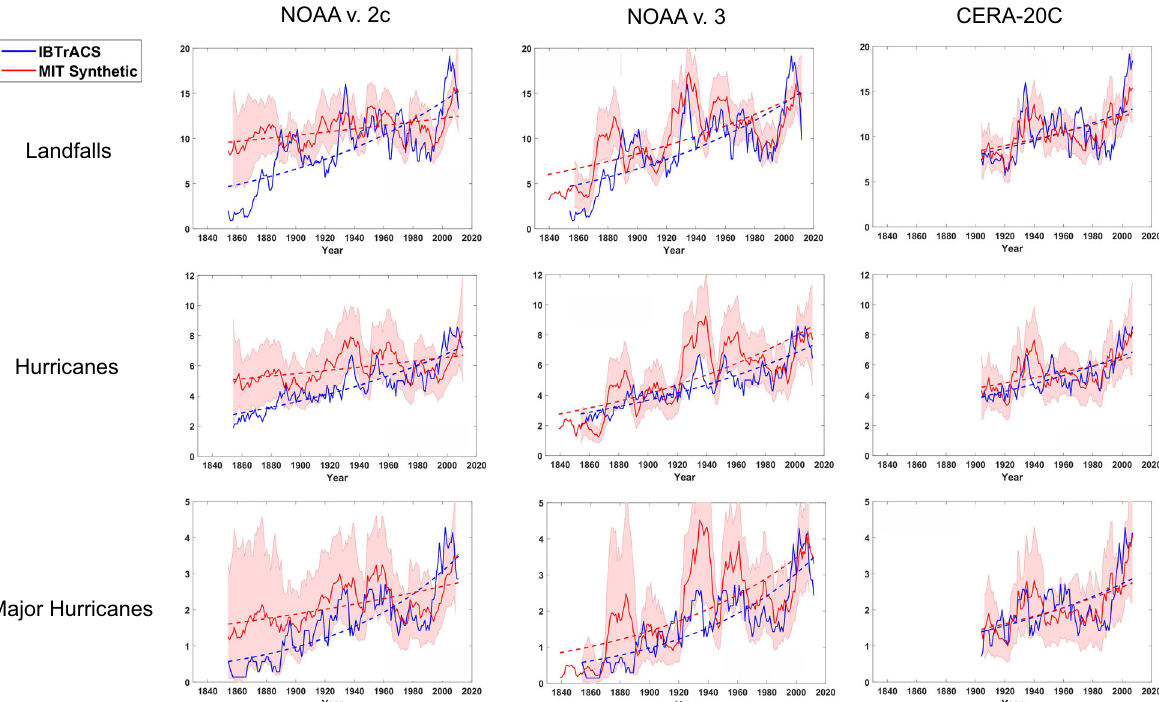
Fig. 1 Time series of North Atlantic landfall events, basin hurricanes, and major hurricanes. The landfall frequency (top row) includes only storms whose lifetime maximum winds speeds exceed 40 kts (21 ms − 1 ). Middle row shows basin frequencies and bottom row shows basin-wide major hurricane frequency. Red curves show quantities associated with tropical cyclones downscaled from three global climate reanalyses (left to right) and blue curves are derived from uncorrected historical tropical cyclone (IBTrACS) data. All quantities have been smoothed with a 7-year running mean. The downscaled counts have been multiplicatively rescaled to match the mean of the last 50 years of the historical data. The dashed curves show the Poisson regressions of the downscaled and historical data. The shading around the downscaled counts shows the bounds within which 90% of subsamples of the downscaled data lie, with the subsample size equal to the historical